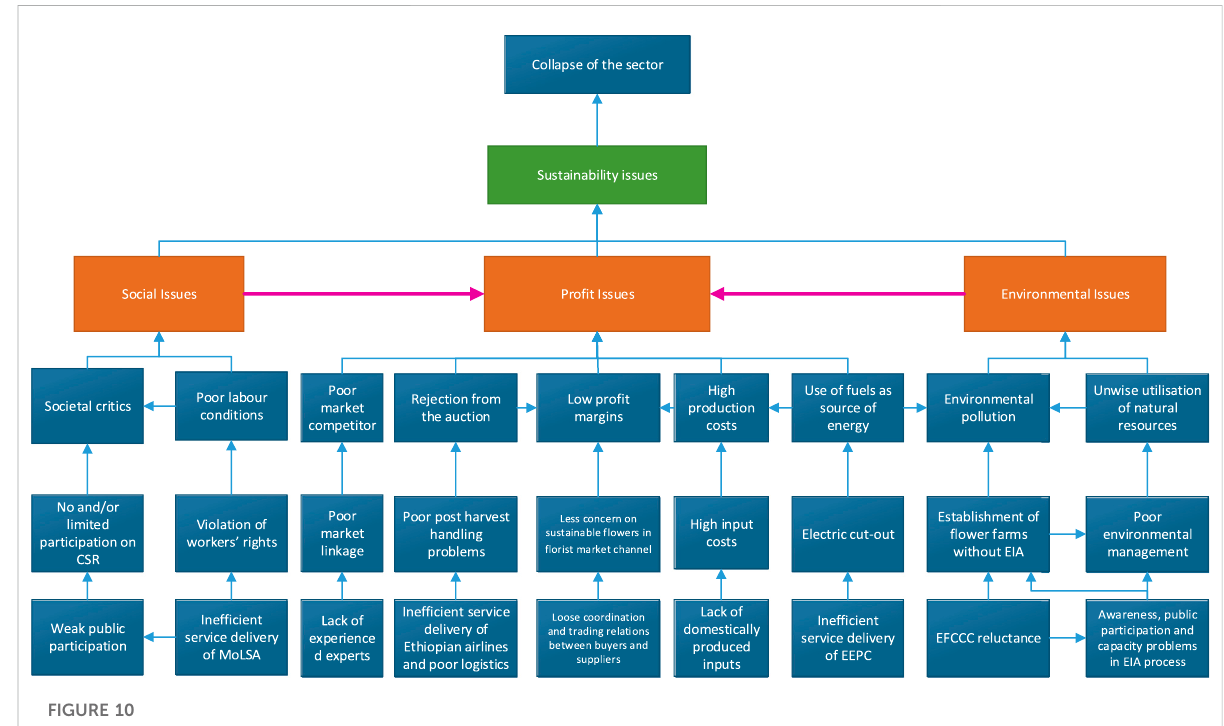
FIGURE 10 Analysis of the root causes of sustainability issues of fl oriculture in